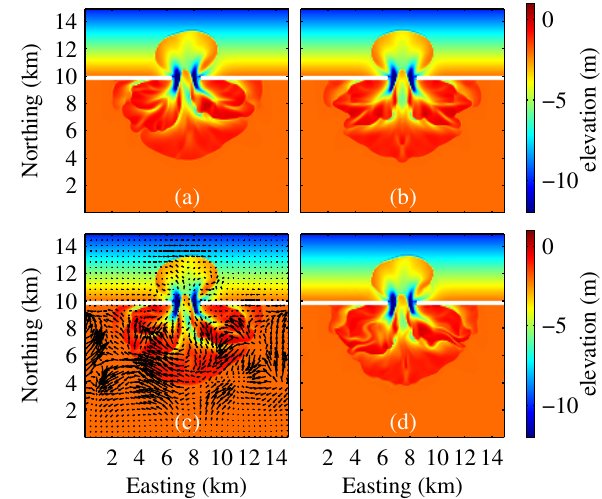
Fig. 3. Example of the image warp: (a) the “observations”, calcu- lated using Delft3D with Coriolis at 53 ◦ N; (b) the predictions, cal- culated at 0 ◦ ; (c) the backward displacement vector field B of the observations towards the predictions, shown on top of the observa- tions; and (d) the predictions deformed to more closely match the observations.